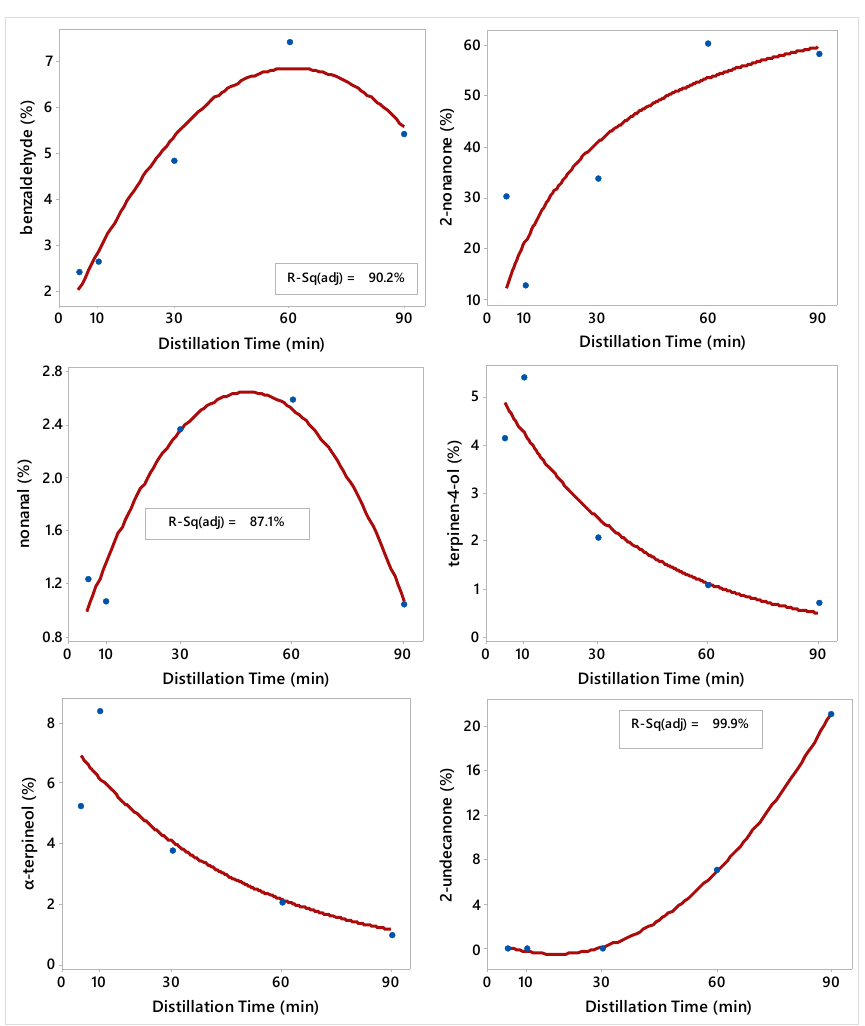
Figure 1. Plot of Distillation Time (DT) vs. the concentrations of six constituents of R. graveolens fruit www.mdpi.com/journal/molecules along with the fitted second-order polynomial, Michaelis–Menten, and Exponential regression models. Adjusted R 2 is given only for the second-order polynomial model, which is linear. The fitted models are: ˆ Y = 1.12 + 0.187 DT − 0.0015 DT 2 (benzaldehyde), ˆ Y = 77.3 DT (2-nonanone), ˆ Y = 0.587 + 0.085 DT − 26.8 + DT 0.0009 DT 2 (nonanal), ˆ Y = 5.56 Exp ( − 0.027 DT ) (terpinen-4-ol), ˆ Y = 7.67 Exp ( − 0.021 DT ) ( α -terpineol), and ˆ Y = 0.79 − 0.146 DT + 0.004 DT 2